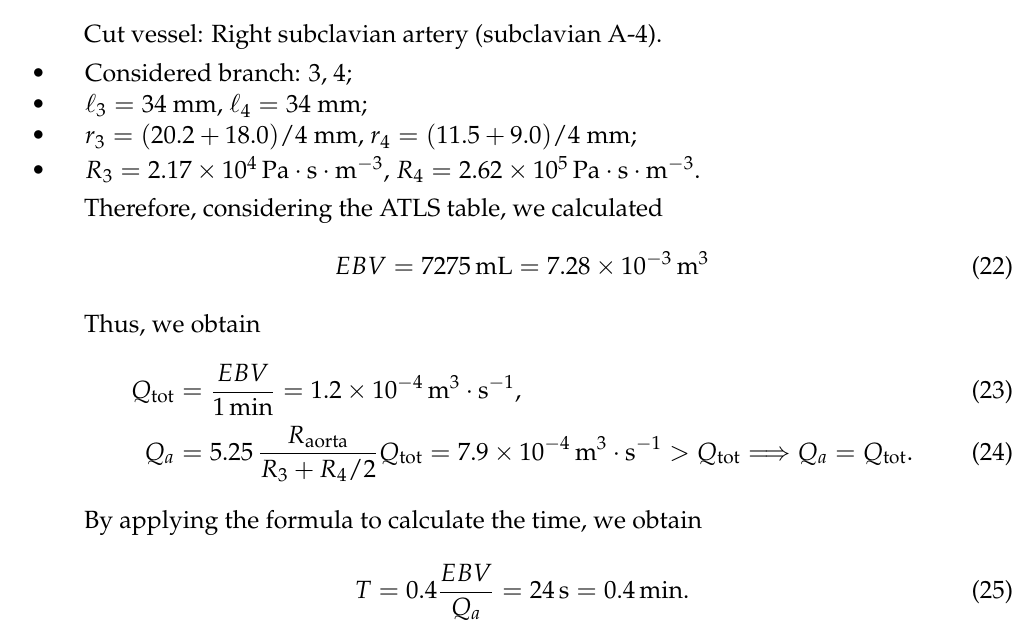
Figure 3. Anatomic representation of right subclavian artery ( top panel , figure from https://www. medicinembbs.com/2011/04/arteries.html, accessed on 10 January 2023); skin injury ( bottom left panel ) and right subclavian artery injury ( bottom right panel ) in the